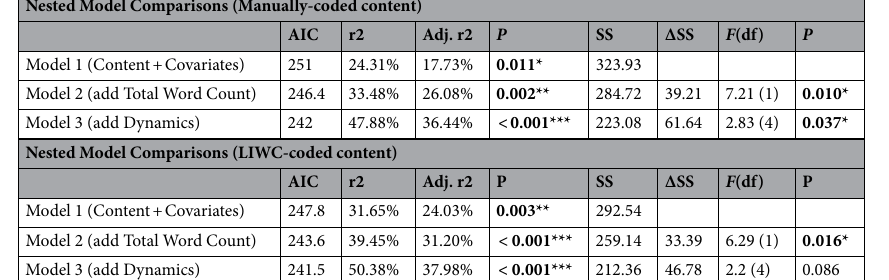
Table 4. Nested model comparisons of content and dynamic models predicting brooding scores. Nested model comparisons assessed the explained variance and overall fit of three models predicting brooding scores. Model 1 for manually-coded content (top) included the significant predictors: valence, % past-orientation, % internal-orientation, censorship, and similarity to daily life. Model 1 for LIWC-coded content included % negative words, % past-oriented words, % first-person pronouns, censorship and similarity to daily life. Model 2 was identical to Model 1 but also included the third covariate of total word count. Model 3 included the same variables as Model 2 as well as mean number of words for positive thoughts, the mean number of words for negative thoughts, and affective transition probabilities from Pos → Pos and Neg → Pos. AIC Akaike Information Criterion, r 2: r squared, adj. r square: adjusted r square, df degree of freedom, SS sum of squares, ∆ SS variation of sum of squares. Highlighted in bold are statistically significant models at p < .05. * P < .05, ** P < .01, *** P <